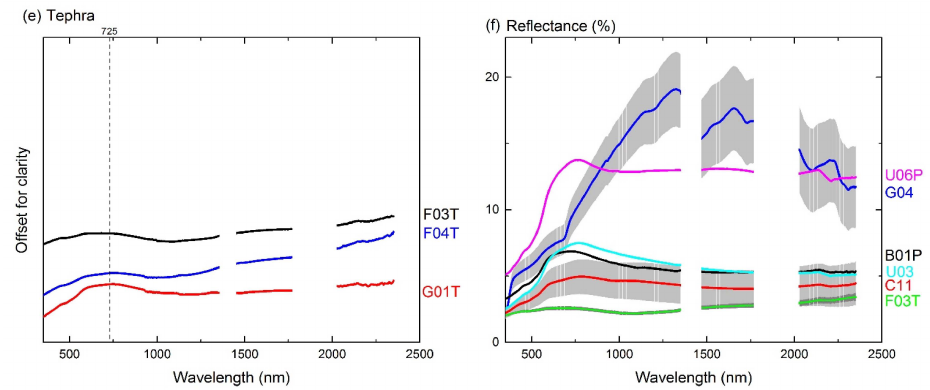
Figure 4. Field reflectance spectra measured at different volcanic sites on Tenerife (vertically offset for clarity). Each curve is the average of ~80 measurements in 20 spots within a 30 ˆ 30 m 2 square. ( a ) Lava sites on the Chahorra (C), Fasnia (F) and Boca Cangrejo (B) lava flows; ( b ) lava sites on prehistorical lava flows in the caldera (U); ( c ) lava sites on the Garachico (G) lava flow; ( d ) lava sites on Boca Cangrejo (B) and Chinyero (Y) lava flows; ( e ) tephra deposit sites on the Garachico and Fasnia cones; ( f ) absolute reflectances for selected sites. Grey background behind spectral curves are standard deviations of reflectance at each wavelength for sites C11, F03T and G04, measured from the standard deviation of the 20 spots measurement per site. Wavelengths corresponding to significant spectral features are indicated by dashed lines. The sites whose names end with a “P” or “T” were measured on p¯ahoehoe lava surfaces and tephra fields, respectively. All other sites were measured on ‘a‘¯a lava surfaces. Spectral ranges centered around 1400, 1900 nm and beyond 2350 nm are removed due to high